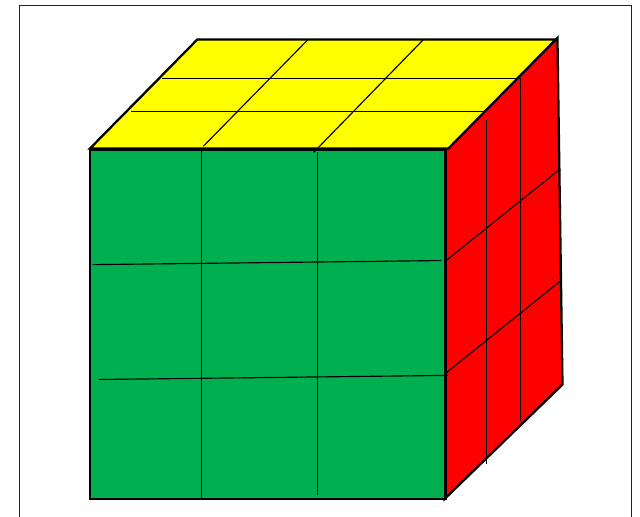
FIGURE 2 | Rubik’s cube